Question: In a single sentence, describe what this figure presents.
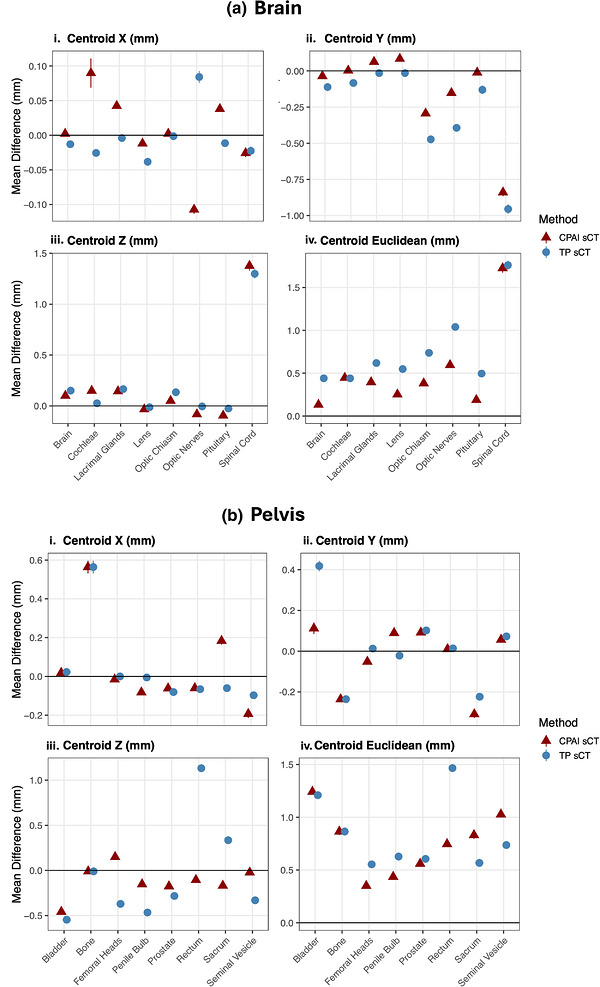
Answer: Differences in centroid location on sCT contours compared to the reference‐CT for (a) brain and (b) pelvic patients. Both sCT contour sets, CPAI and TheraPanacea (TP), were used for analysis. Differences were measured in the (i) x‐direction (left‐right), (ii) y‐direction (anterior‐posterior), (iii) z‐direction (superior‐inferior), and (iv) Euclidean distance. The bladder and seminal vesicle were excluded from pelvic subplot iv due to inconsistent contouring. Error bars were derived from standard error of the mean.